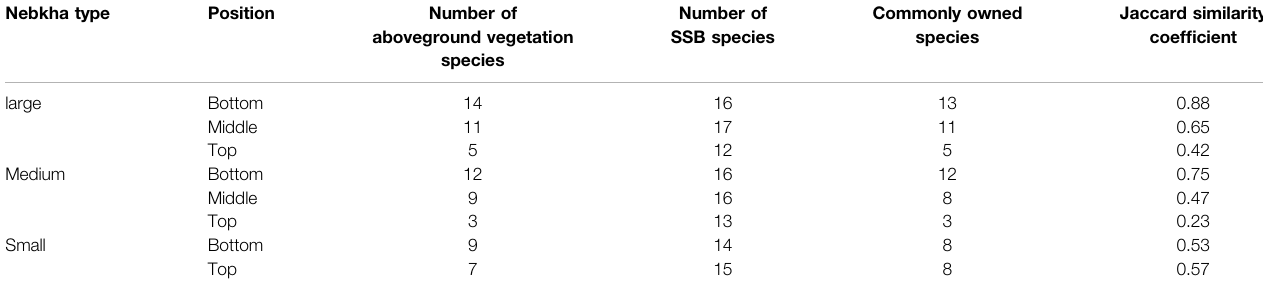
TABLE 5 | Similarity between soil seed bank (SSB) and aboveground vegetation in different parts of nebkhas. Nebkha type